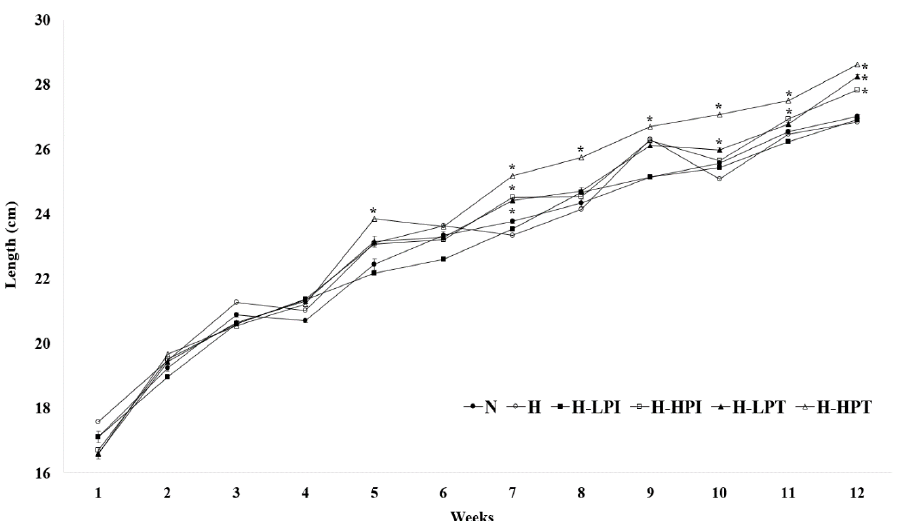
Figure 4. Changes in body length between groups. Symbol (*) corresponds the statistical difference between intervention groups versus inhalation of patchouli essential oil by the non-parametric Friedman test followed by Dunn’s test ( p < 0.05).